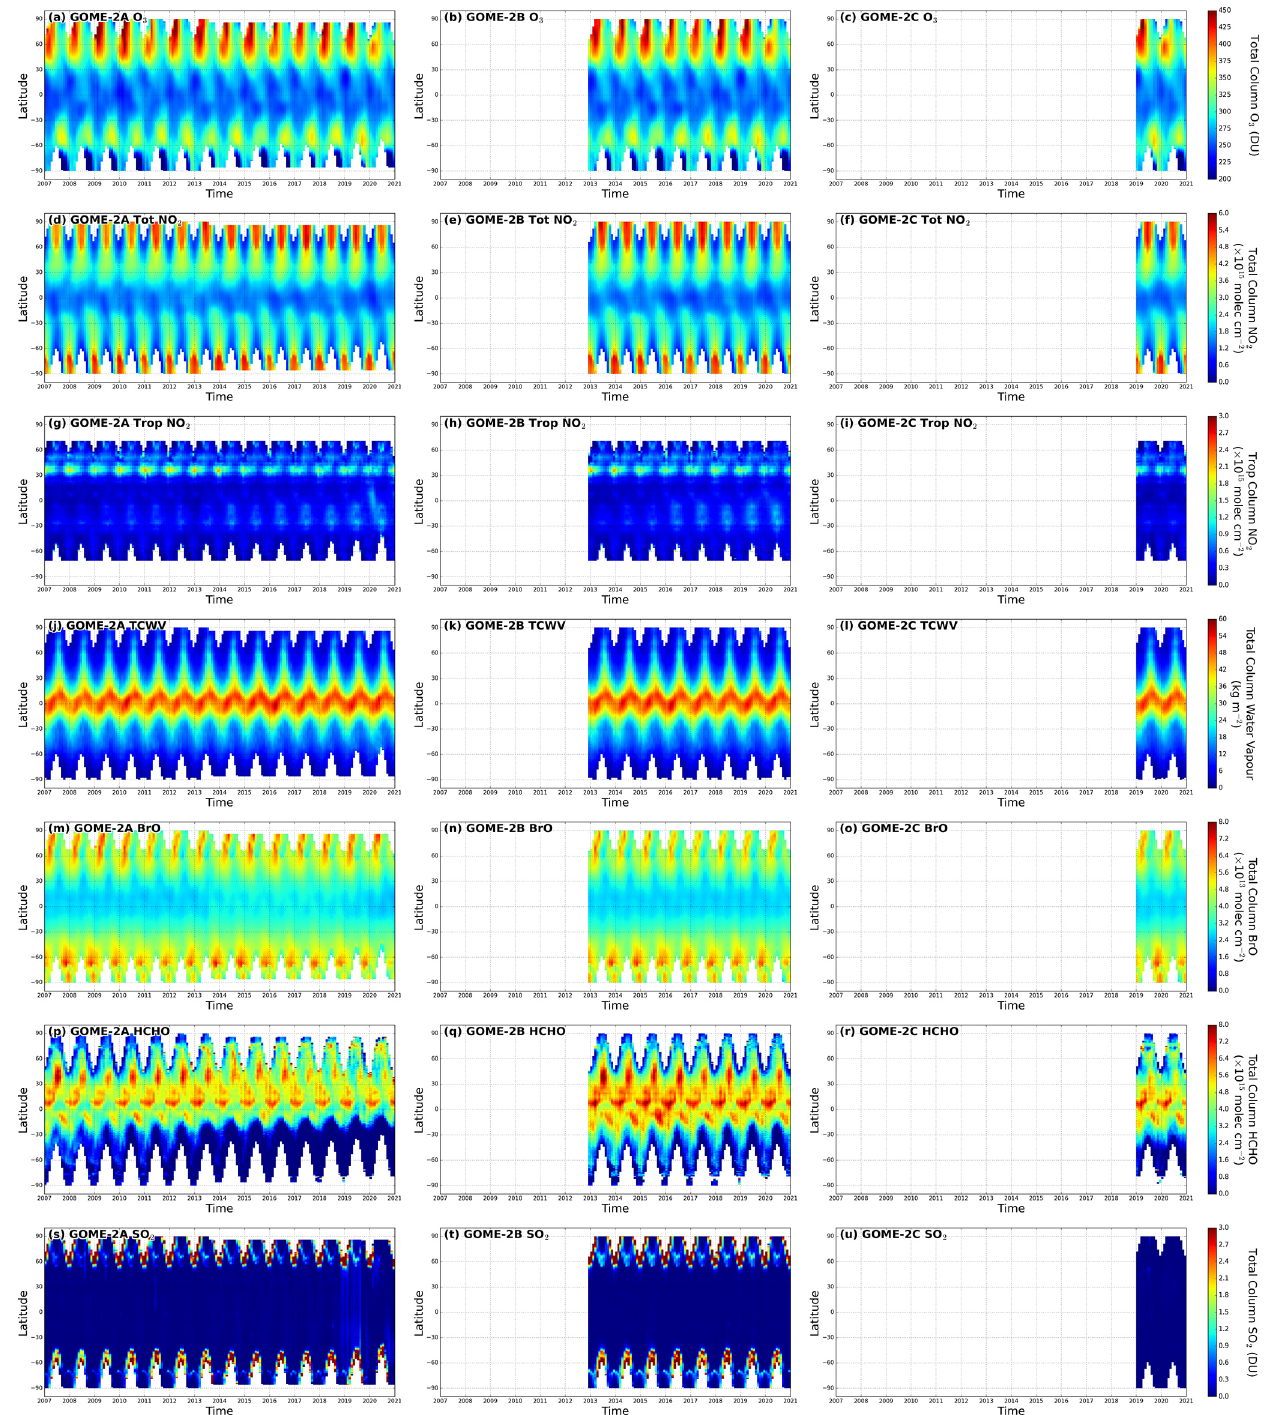
Figure 11. Monthly zonal average of total column O 3 (first row), total column NO 2 (second row), tropospheric column NO 2 (third row), total column water vapour (fourth row), total column BrO (fifth row), total column HCHO (sixth row), and total column SO 2 (seventh row). Data from GOME-2A (first column from the left), GOME-2B (second column from the left), and GOME-2C (third column from the left) are shown.